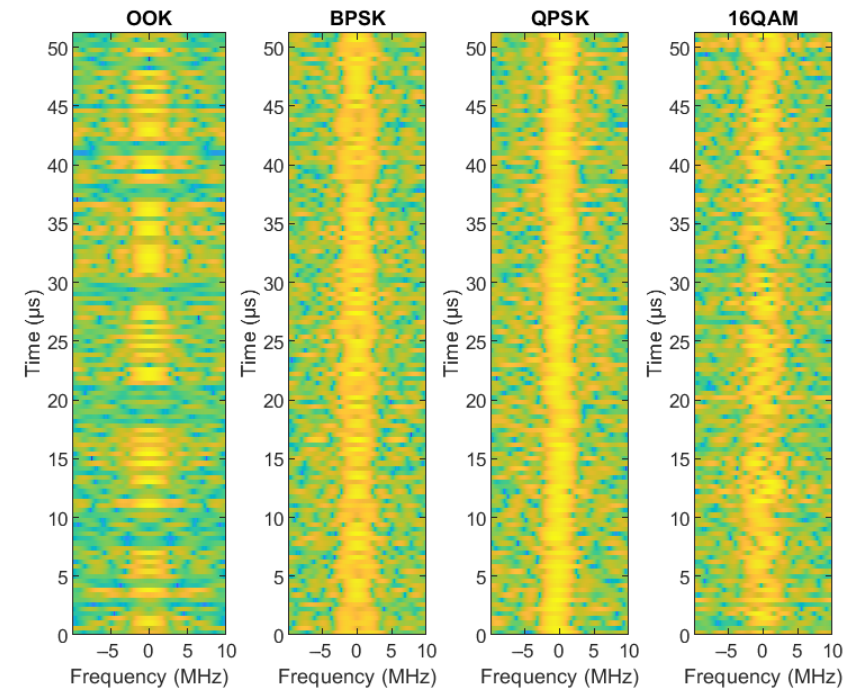
Figure 6. Spectrogram of the example frames. Weak turbulence with SNR = 10 is as an example above.